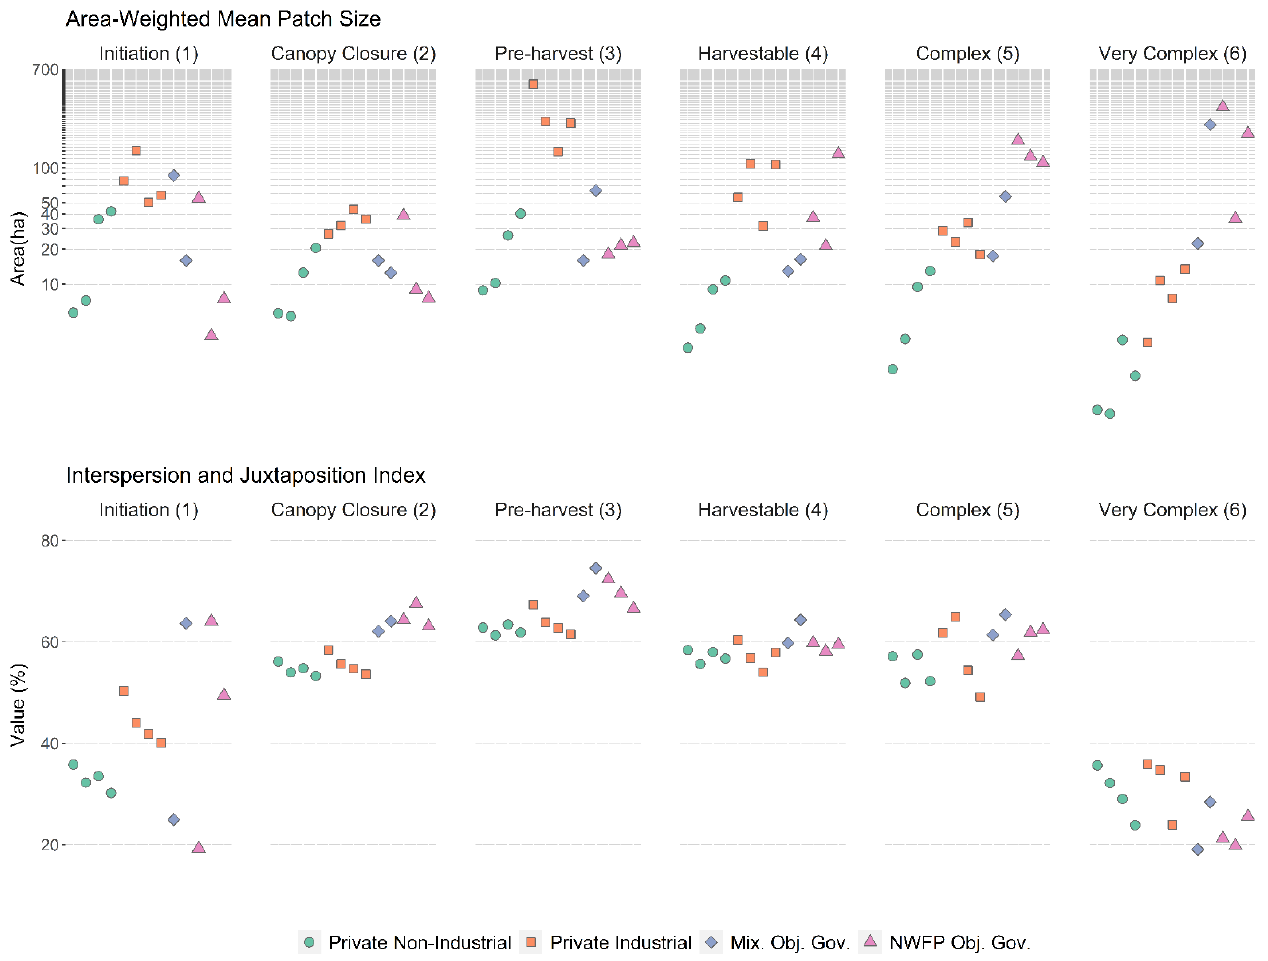
Figure 6. Values of mean patch size and interspersion and juxtaposition index for the 13 ownership types. Each point represents the value of one of the thirteen ownership types, but for ease of visualization, symbols and colors denote one of the four ownership groups. Mean patch size is on a log scale but to aid in interpretation the y -axis labels are not trans- formed.